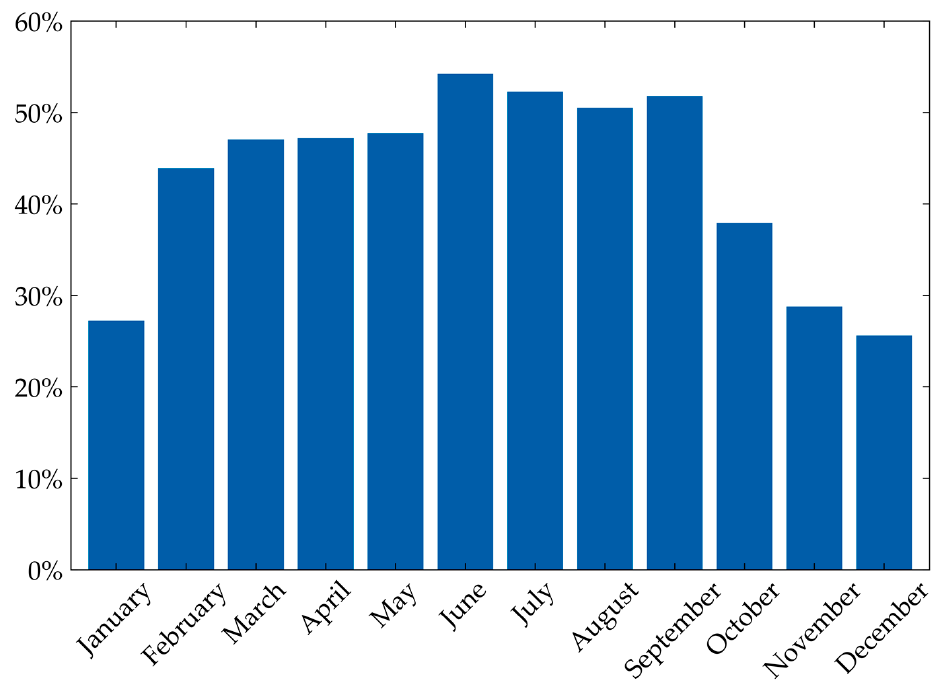
Figure 14. PV electricity load coverage per month after the renovation of the room.